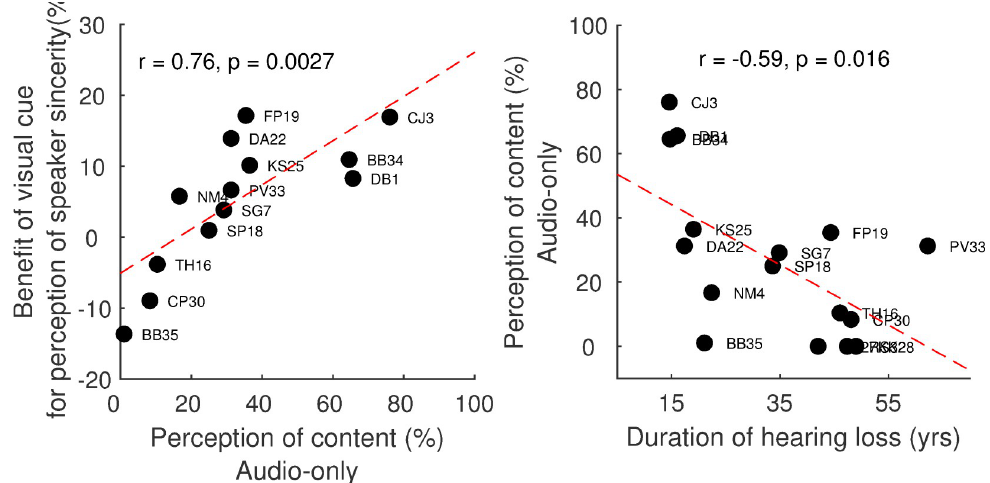
Fig 3. Left panel: The relationship between the advantage of visual cues in identifying speakers’ sincerity and perception of content in the audio-only condition. Right panel: Correlation between the perception of content in the audio-only condition and duration of hearing